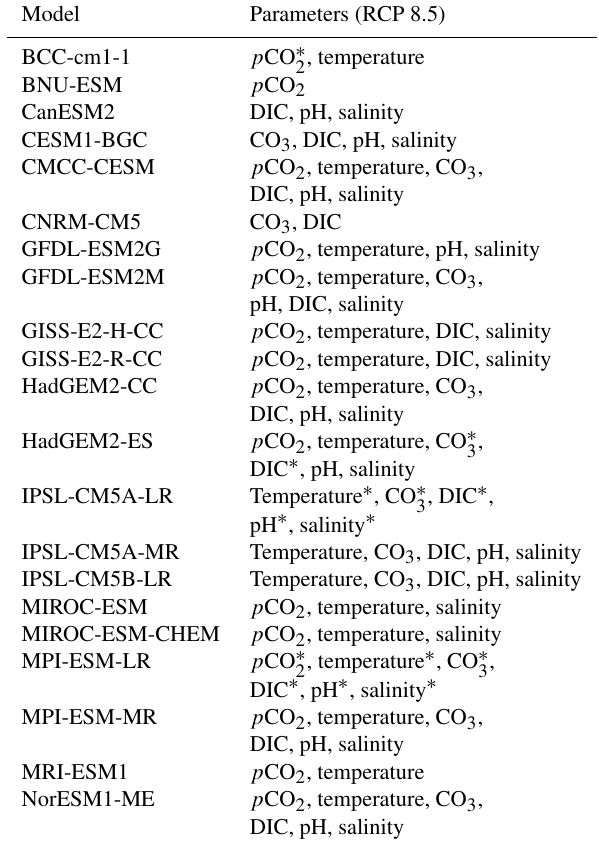
Table 2. CMIP5 ESMs used in this study containing ocean carbon- ate parameters. (cid:127) Ar and (cid:127) Ca were calculated from the model sea surface temperature, sea surface salinity, and CO 3